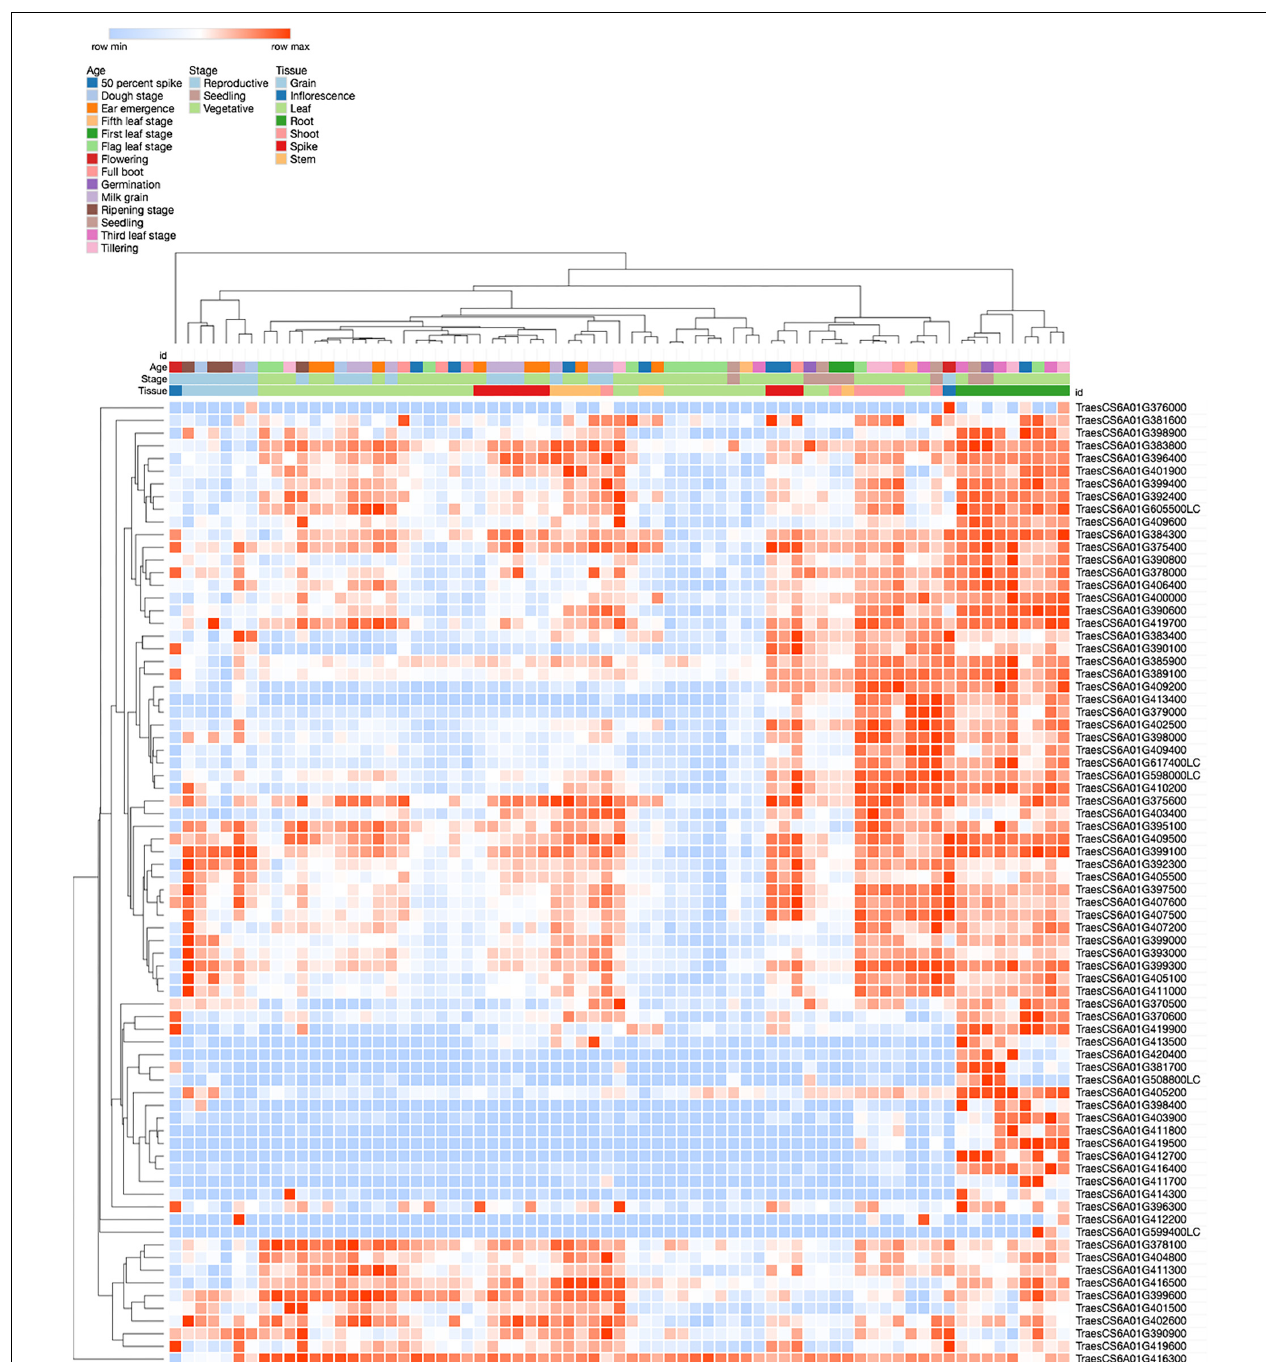
FIGURE 9 | Expression patterns of bread wheat homologs at different age, stage, and tissue specific RNAseq libraries. Heatmap (blue = low; red = high) displayed high expression in root tissues (green) during seedling (pink) and vegetative stage (light green). Genes primarily expressed in the root tissues at seedling and vegetative stages are listed in Table 2